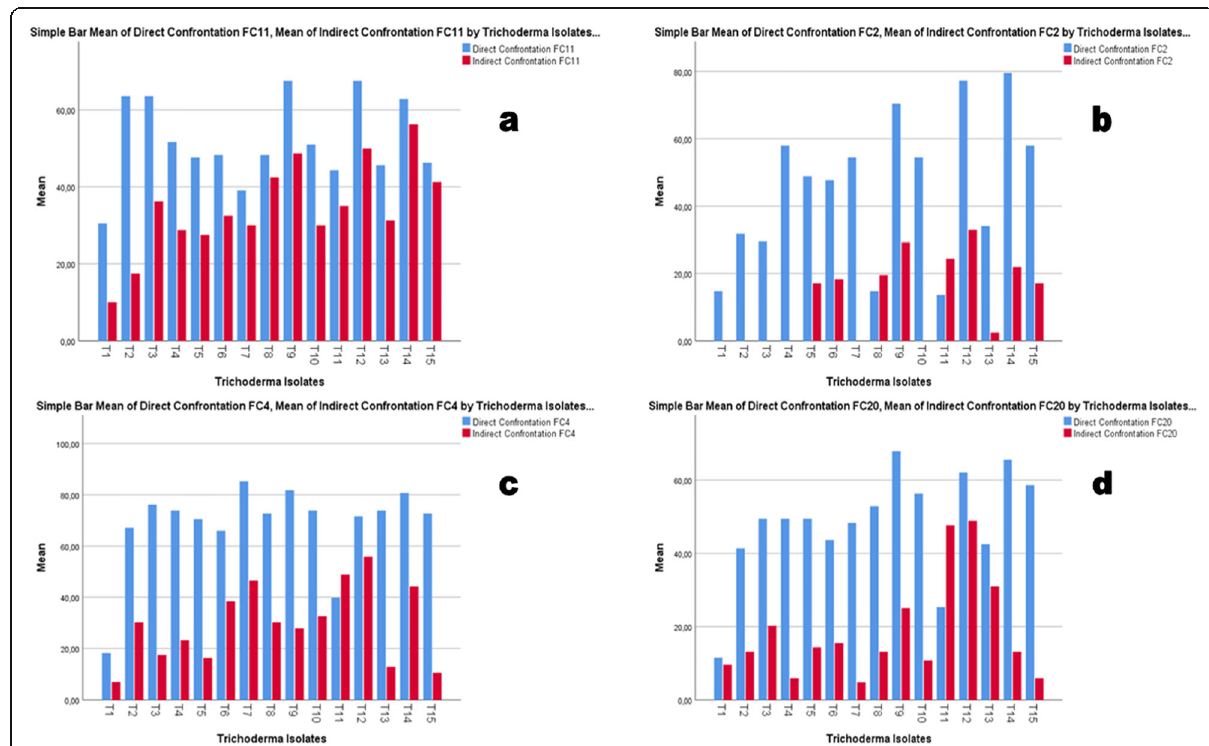
Fig. 3 Histograms of in vitro confrontation (direct and indirect) between Trichoderma isolates against F. culmorum FC11 ( a ), FC2 ( b ), FC4 ( c ), FC20 ( d )